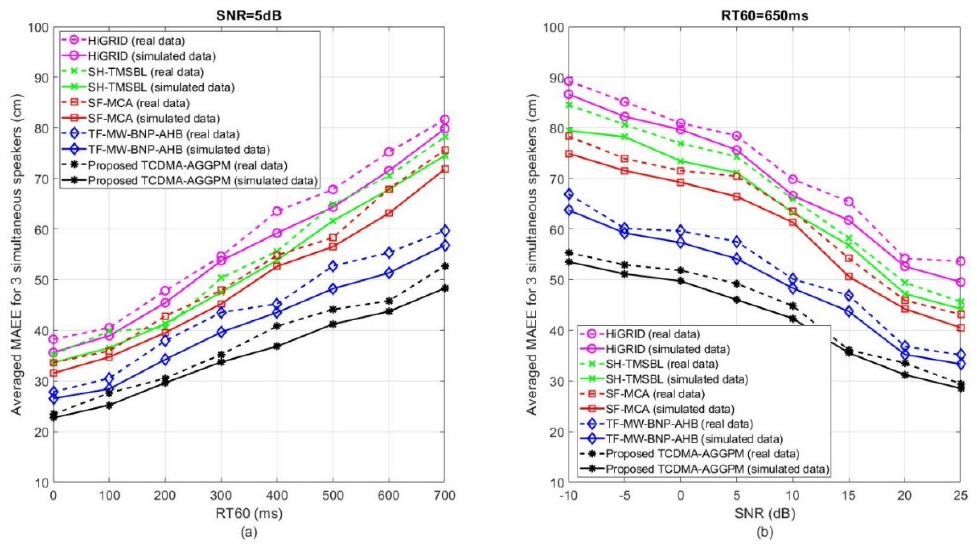
Figure 7. The averaged MAEE results (in cm) for the proposed TCDMA-AGGPM algorithm in comparison with HiGRID, SH-TMSBL, SF-MCA, and TF-MW-BNP-AHB methods, for 3 simultaneous speakers on real and simulated data, ( a ) for SNR = 5 dB and 0 ≤ RT 60 ≤ 700 ms, and ( b ) for RT 60 = 650 ms and − 10 dB ≤ SNR ≤ 25